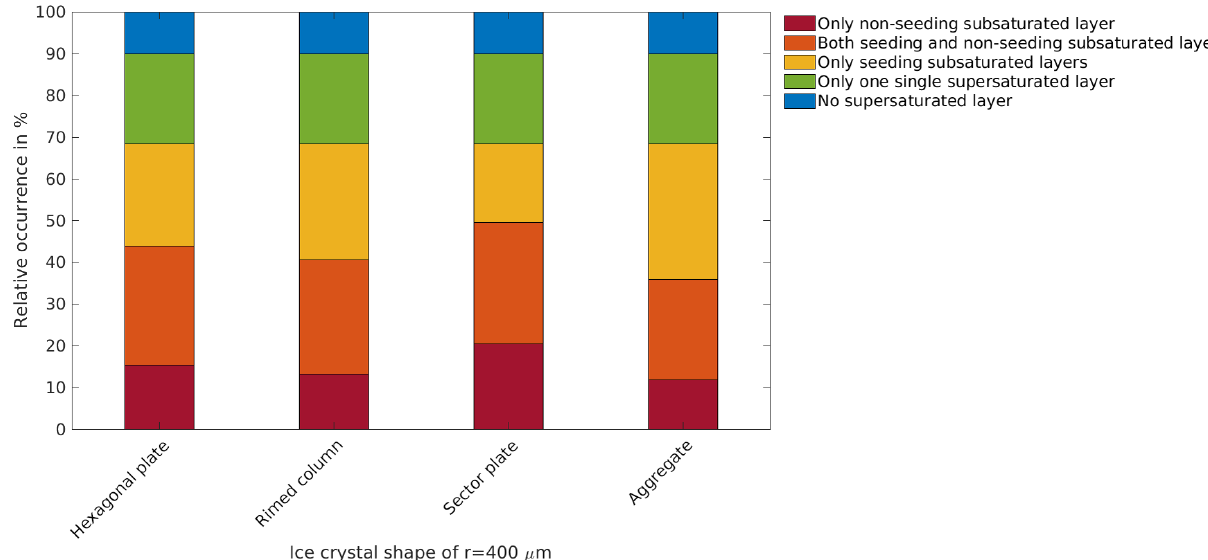
Figure A1. Cloud occurrence derived by using classification step 2 using the four different ice crystal shapes: hexagonal plate, rimed column, sector plate and aggregate. The initial ice crystal size is r =